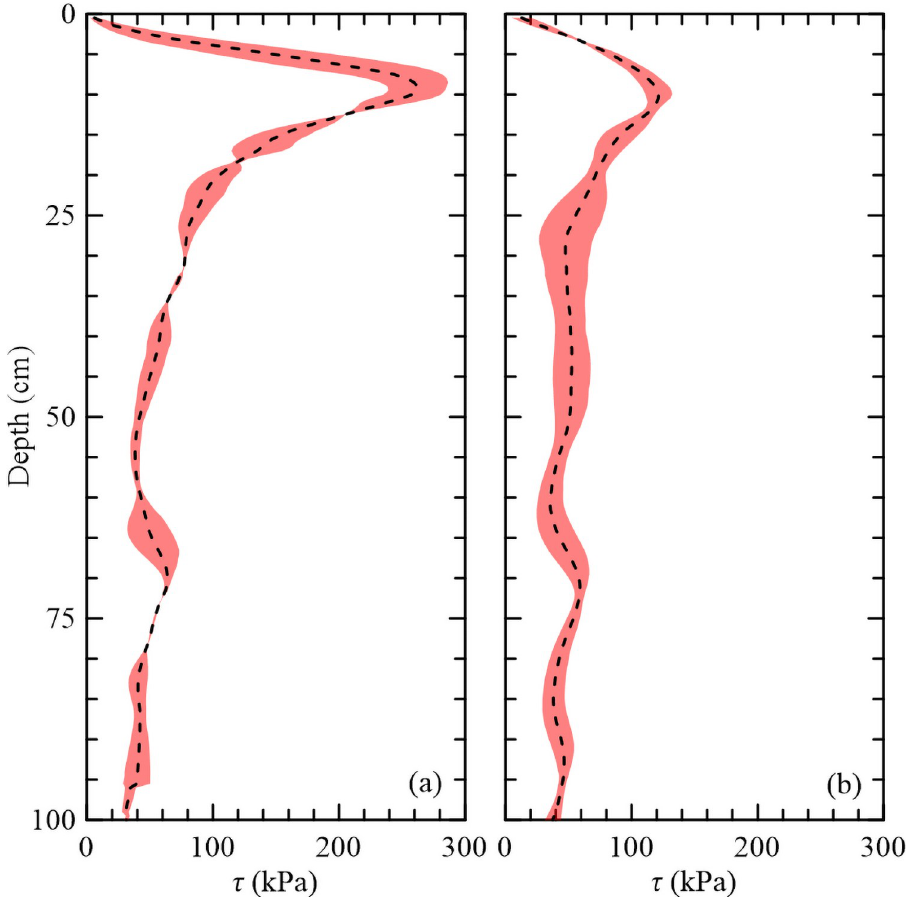
stable (i.e., no discernable deterioration) over the past three decades based on time-lapse aerial images. Due to time constraints, all coring equipment was being utilized within the nourished area so no soil cores were collected. The average shear strength values ± 1 SD bands for both forms of vegetation are shown in Fig 8. For the short-form, the peak shear strength of 263 kPa was found at a depth of 11 cm and the root depth was recorded down to 40 cm. The tall-form